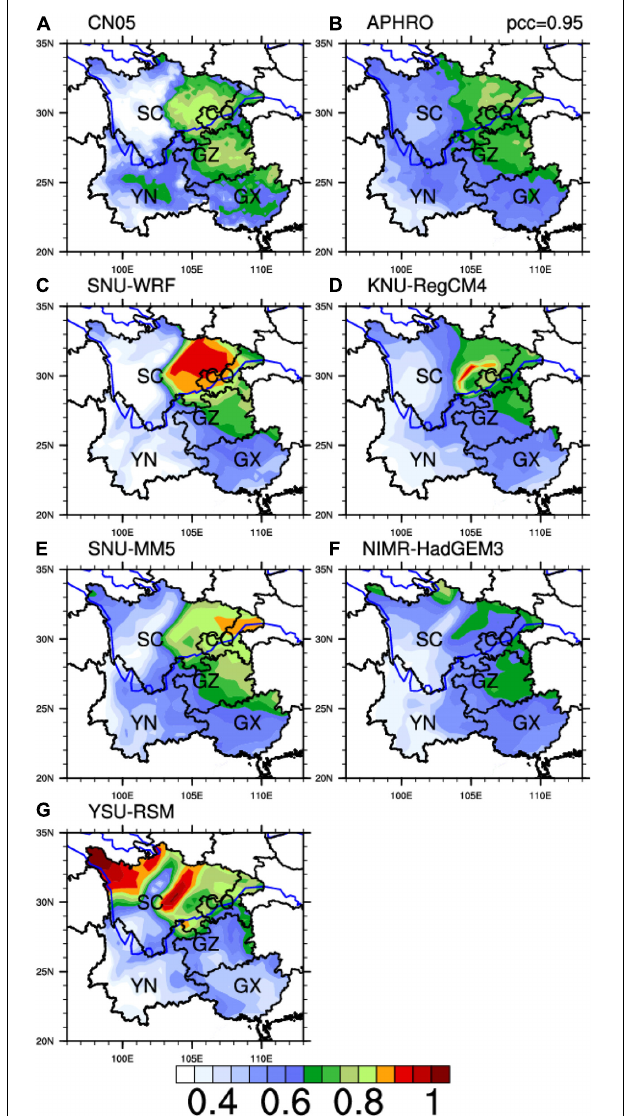
FIGURE 3 | Spatial distributions of dry day occurrence (unit:%) from two observations, (A) CN05 and (B) APHRO, and five RCM simulations, (C) SNU-WRF, (D) KNU-RegCM4, (E) SNU-MM5, (F) NIMR-HadGEM3, and (G)